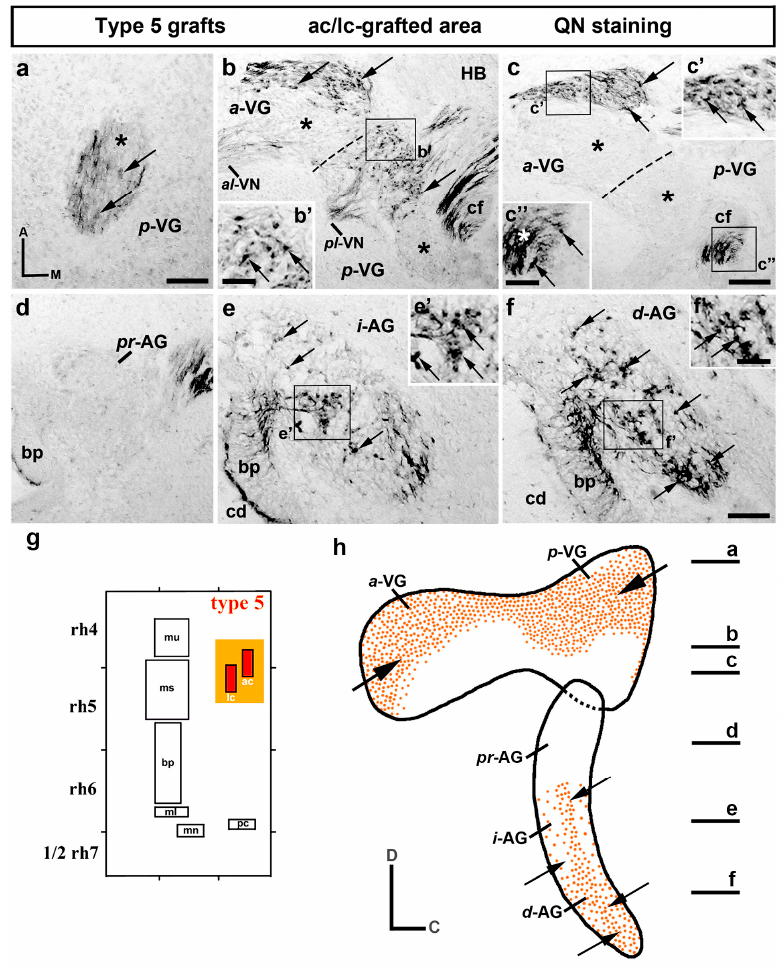
Figure 5. Graft-derived quail ganglionic neurons from the extended area of the anterior and lateral cristae (type-5 grafts; n = 7). ( a – f ) Horizontal sections through the vestibular (VG in ( a – c ) and acoustic (AG in ( d – f )) ganglia. QN-stained grafted quail neurons occupied a large portion of both the anterior and posterior vestibular ganglion ( a -VG and p -VG; arrows in ( a – c’ )). The asterisks in b and c indicate the areas devoid of ac/lc-grafted neurons. In the AG ( d – f ), the pr -AG did not display any quail neurons ( d ). In the i -AG and d -AG, QN-positive neurons were clearly observed (arrows in ( e – f’ )). ( c’’ ) The white asterisk indicates axons in the cochlear fascicle (cf). ( g ) Schematic representation of the type-5 grafts performed at the 10-somite stage, considering the expanded sensory area of the anterior and lateral cristae (ac and lc; dark and light orange areas). ( h ) Diagram summarizing the results, in which horizontal sections are indicated. The arrows point to the most signi fi cant accumu- lations of grafted quail neurons. Orientation: A, anterior; C, caudal; D, dorsal; M, Medial. Additional abbreviations: al -VN, anterolateral vestibular nerve; bp, basilar papilla; cd, cochlear duct; HB, hind- brain; pl -VN, posterolateral vestibular nerve. Scale bar = 9 µm in ( a ); 8 µm in ( b’ , c’ ); 10 µm in ( c’’ ); 19 µm in ( b , c ); 12 µm in ( d , e , f ); 6 µm in ( f’ ).